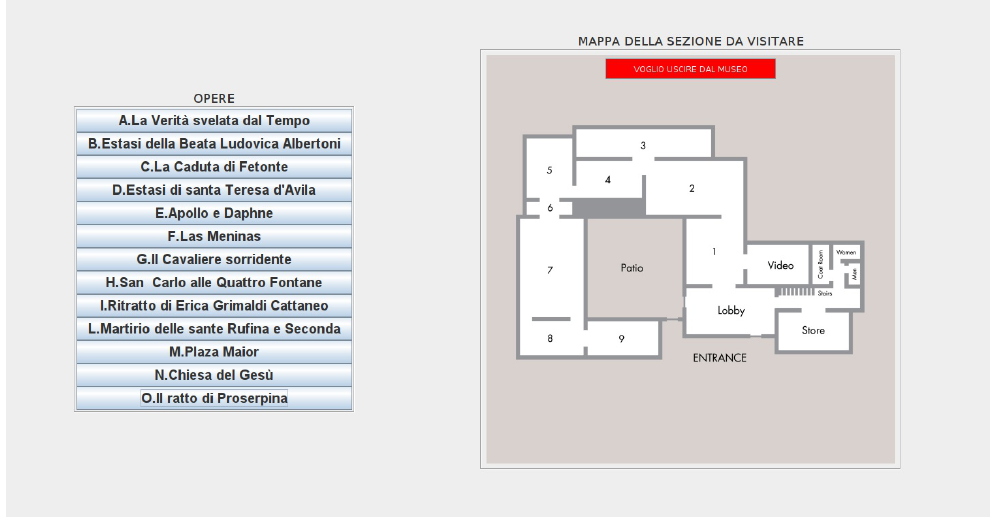
Figure 2. The virtual museum is organized as follows: to the left are enumerated the artworks that can be visited during the tour, while to the right there is the map of the tour. The red button over the map allows the closing of the tour. Please notice the numbers on the map indicate the number of rooms in the museum (room 1, room 2), while the letters before each artwork’s title are used to sort the list of the